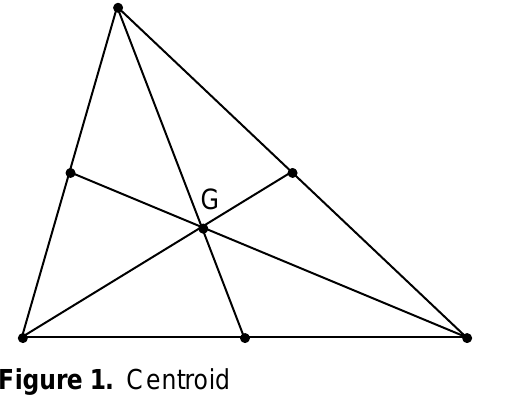
Figure 2. Orthocentre